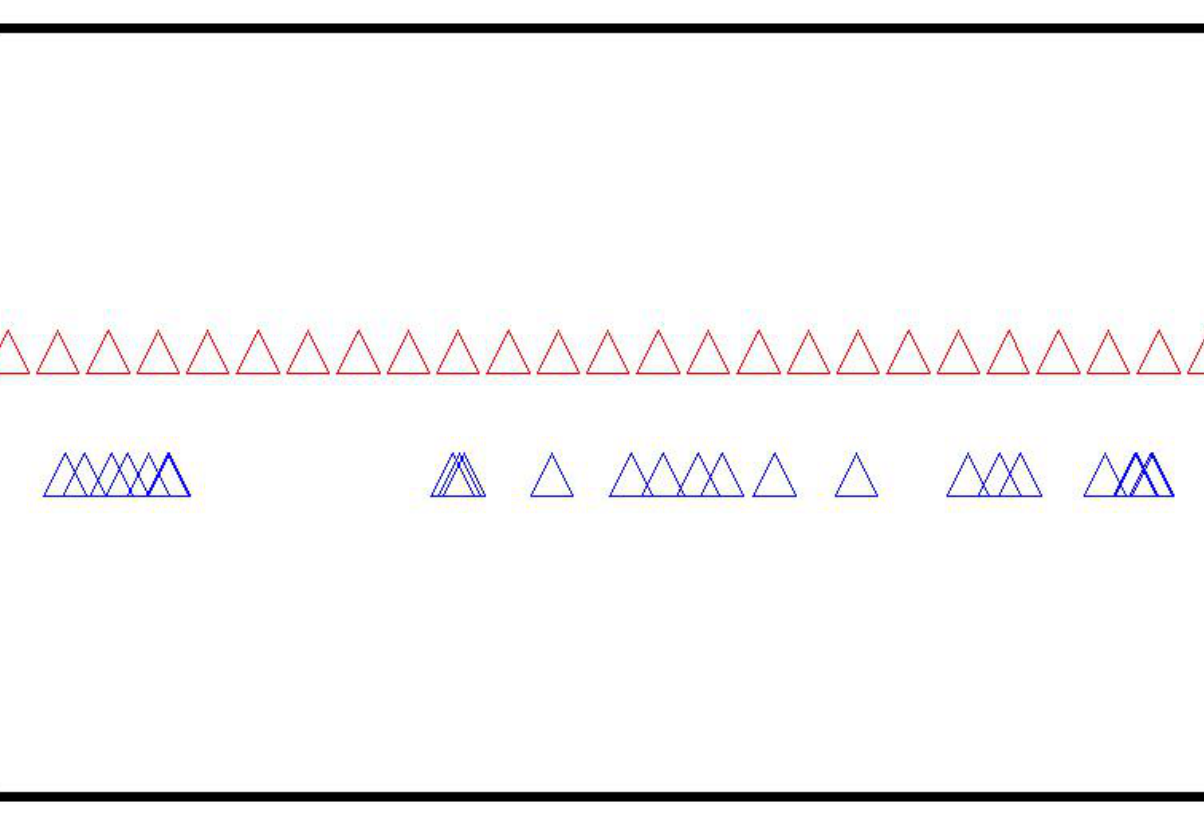
Fig. 1. Comparison of samples ( n = 25) randomly generated from a uniform distribution (blue triangles) to systematically generated, evenly spaced samples (red